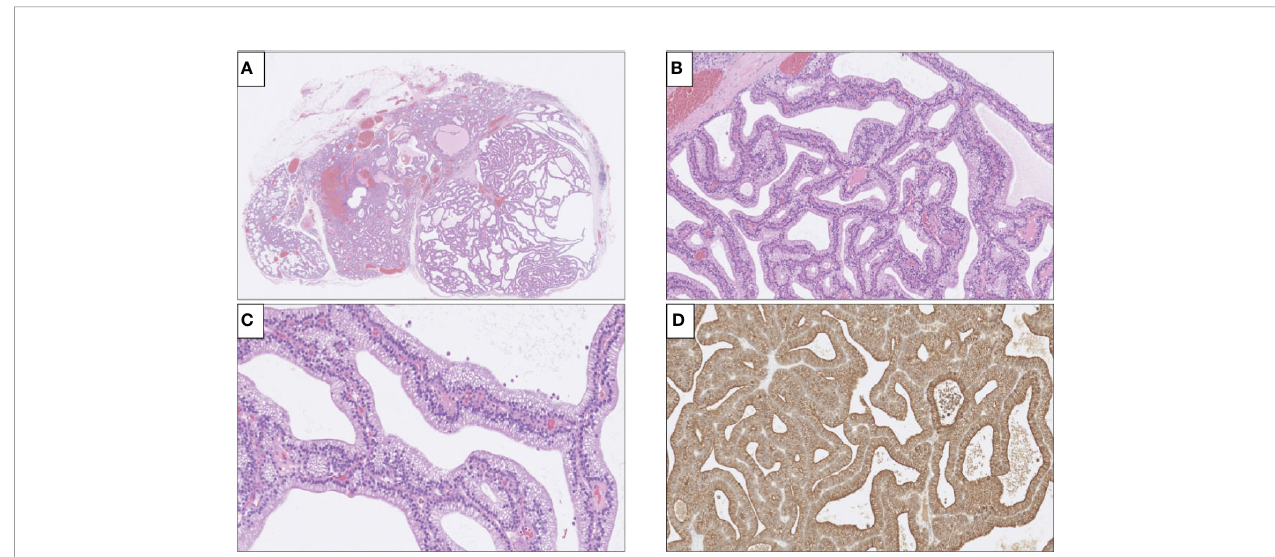
FIGURE 1 | Histological and immunohistochemical attributes of the parathyroid adenoma with respiratory-like epithelium. (A) Hematoxylin-eosin (H&E) stain of the excised lesion depicting a cystic appearance (right), with normal rim of parathyroid tissue to the left. Magni fi cation x20. (B, C) Cells were pseudo-strati fi ed and cylindrical with palisading nuclei and, appearing focally, processes reminiscent of apical cilia, magni fi cation x200 and x400 respectively. (D) Diffuse and strong PTH immunoreactivity was